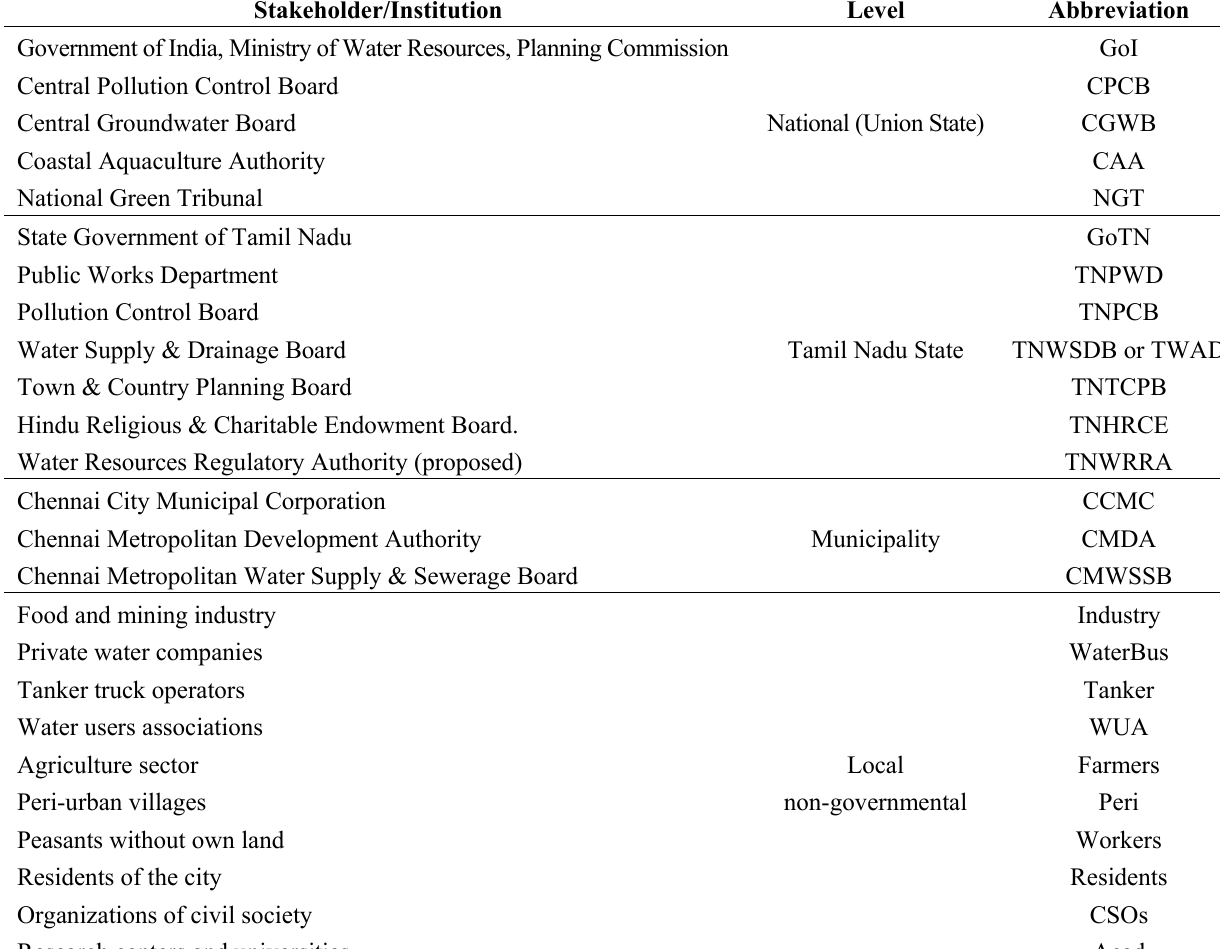
Table 2. List of